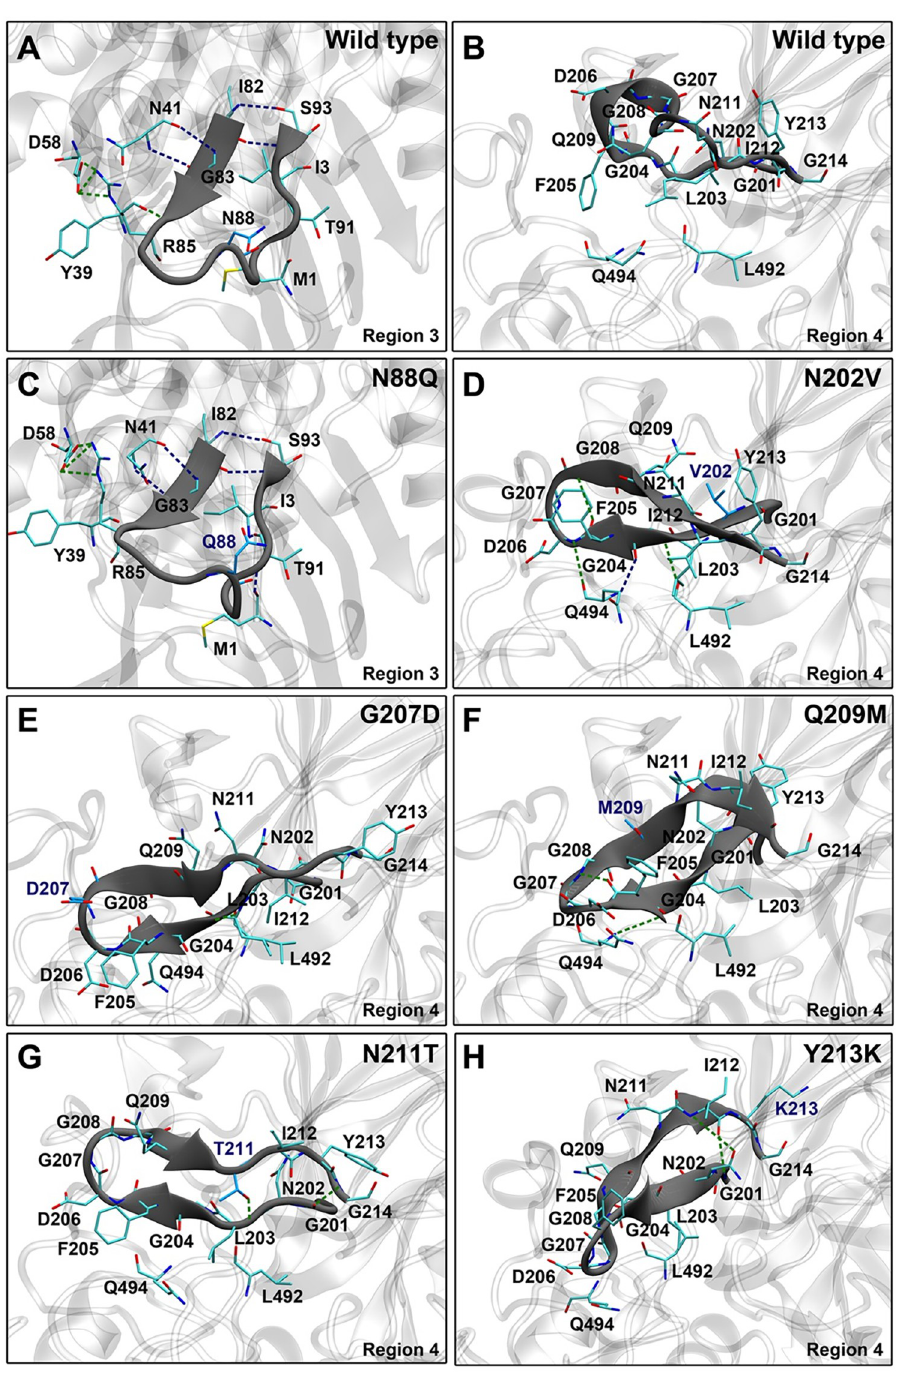
Fig 6. Overall hydrogen bond interactions of the designed regions of the wild type (A-B) are lower than those of the designed mutants (C-H). Strong and medium hydrogen bonds are shown in blue and green dashed lines, respectively.